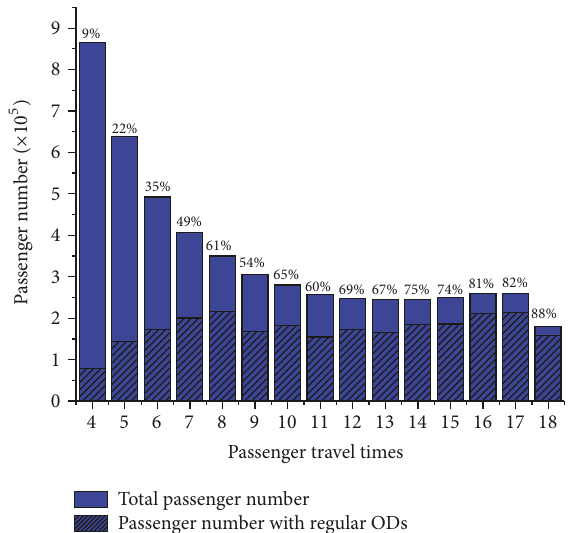
Figure7:PassengernumbervariationwithregularODsfordifferent travel times.